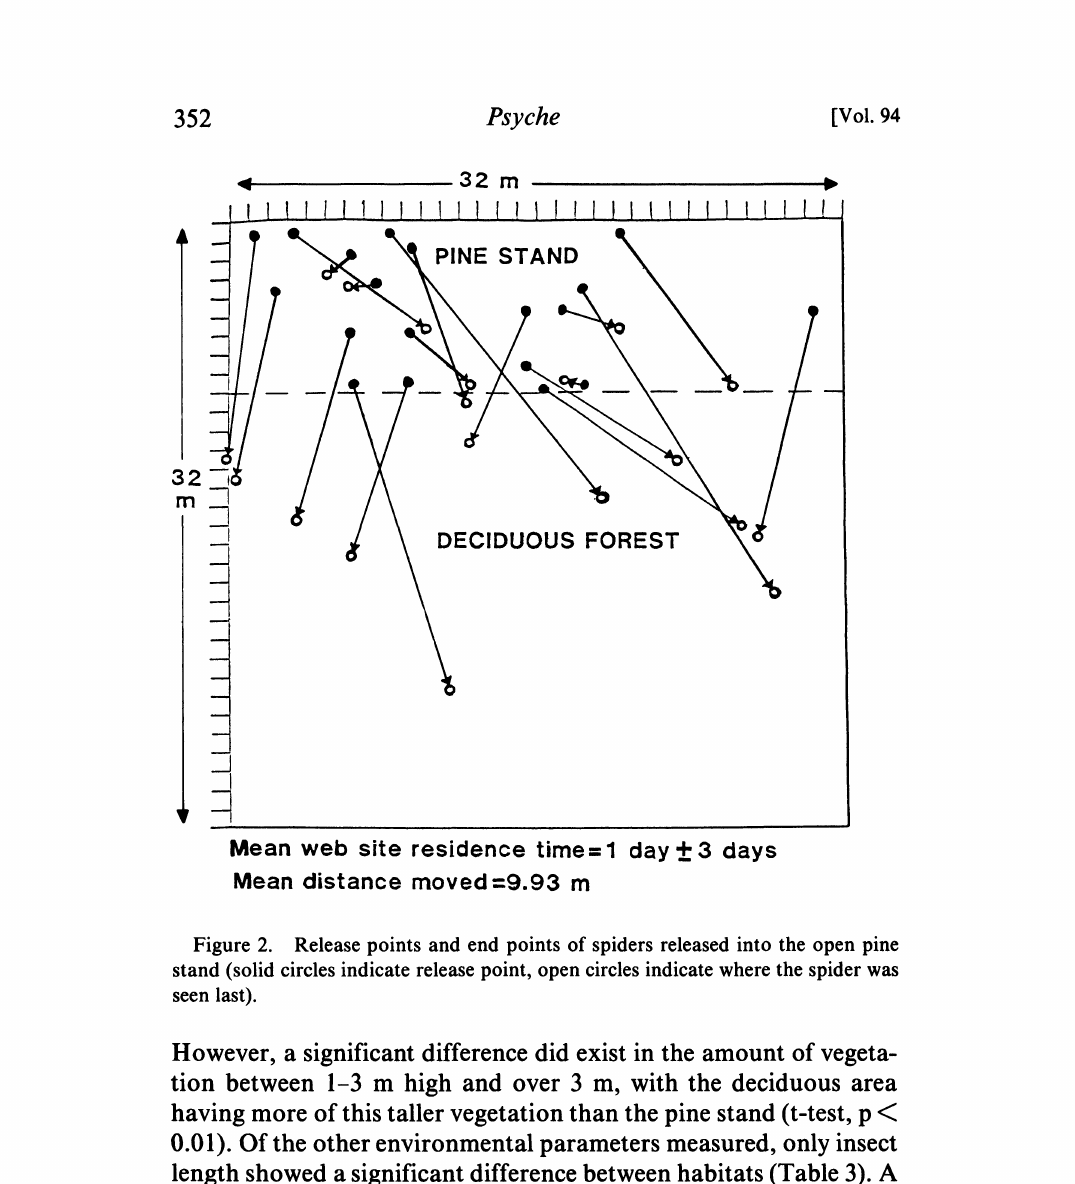
Figure 2. Release points and end points of spiders released into the open pine stand (solid circles indicate release point, open circles indicate where the spider was seen